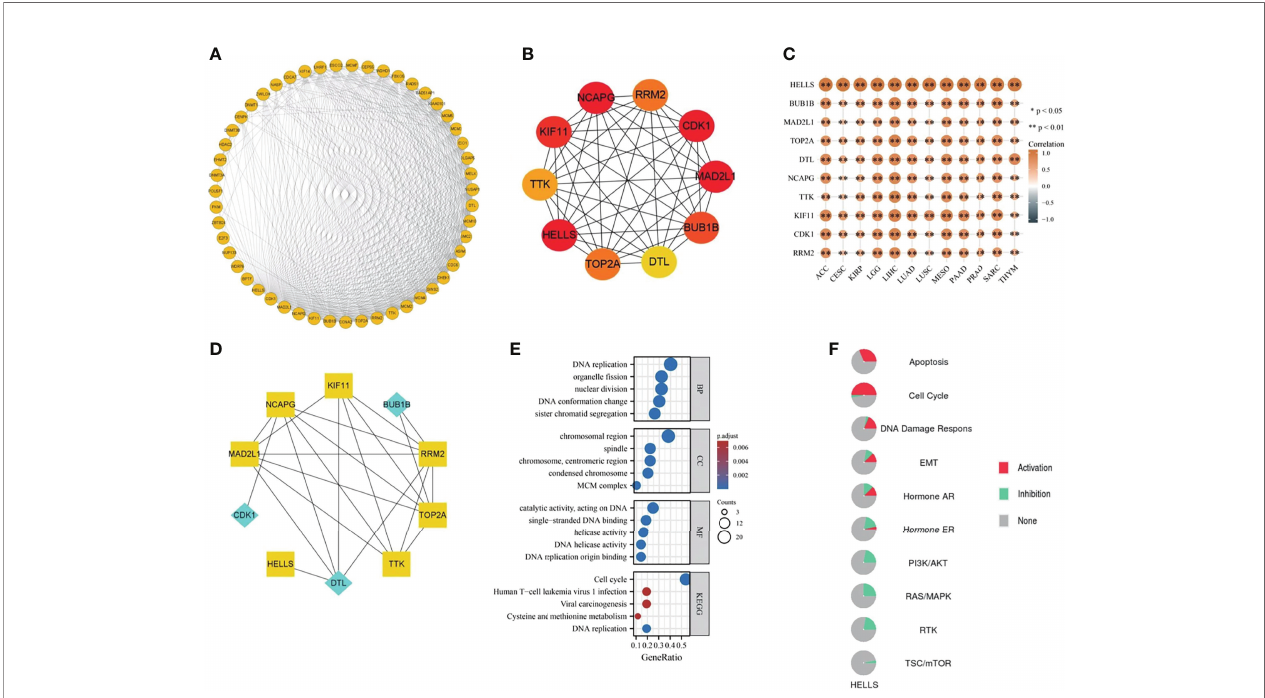
FIGURE 9 | The PPI network and functional enrichment analysis of HELLS. (A) The PPI network of HELLS, (B) The top ten hub genes of PPI network, (C) The association hub gene with HELLS in 12 cancers present as heatmap. ∗ p < 0:05, ∗∗ p < 0:01, (D) The signaling pathway reconstruct form hub genes. Blue diamonds represent receptors and yellow squares represent transcription factors in the signaling pathway, (E) GO/KEGG pathway enrichment for HELLS and closed interact genes, (F) HELLS with pathway activity or